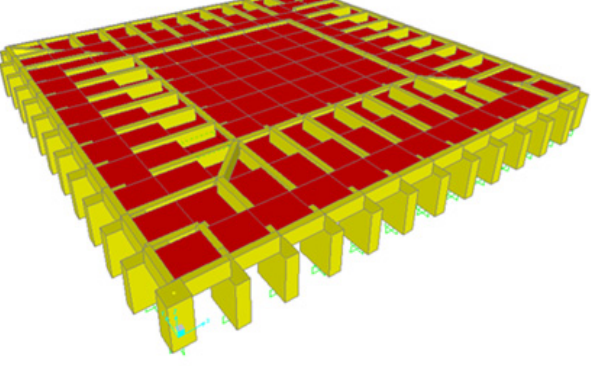
Figure 5. Perspective view of the ground